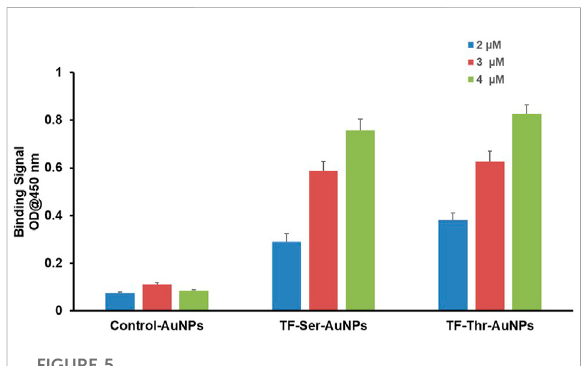
FIGURE 5 Binding of Gal-3 to AuNPs by simple ELISA experiments with AuNP-coated 96-well plates.